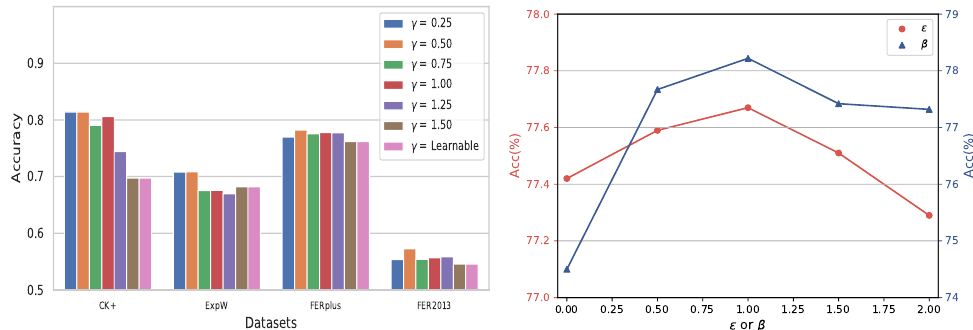
Figure 6. Evaluation of the margin parameter ( γ ), and the trade-off ratios (cid:101) and β